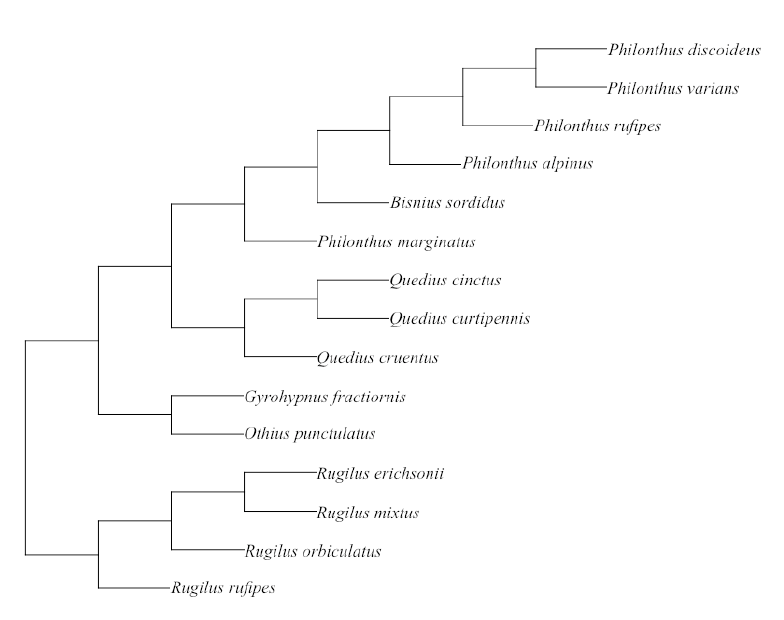
Figure 2. Phylogenetic scheme for the considered species reconstructed from various literature sources as cited in the text.